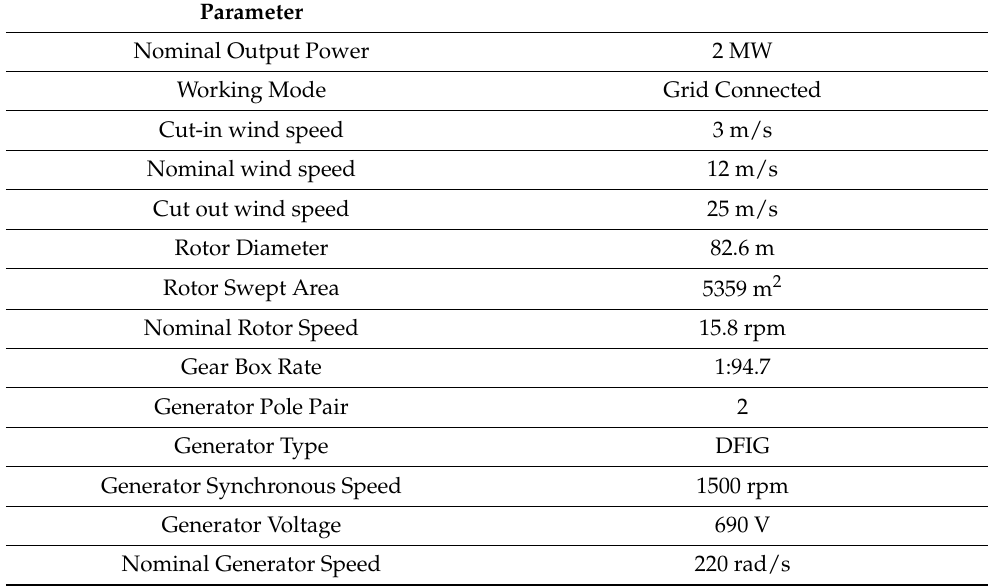
Table 3. Turbine parameters adapted from